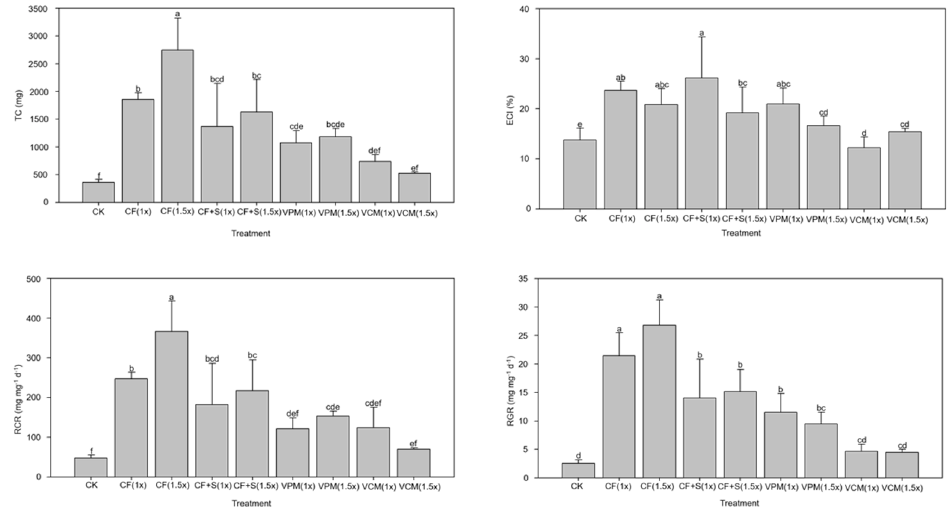
Figure 2. The total consumption (TC), efficiency of conversion of ingested food (ECI), relative consumption rate (RCR), and relative growth rate (RGR) of Spodoptera litura larvae in the short-term feeding trial. (The meanings of the codes are the same as in Table 2. Means within a column followed by the same letters are not significantly different at p < 0.05.)